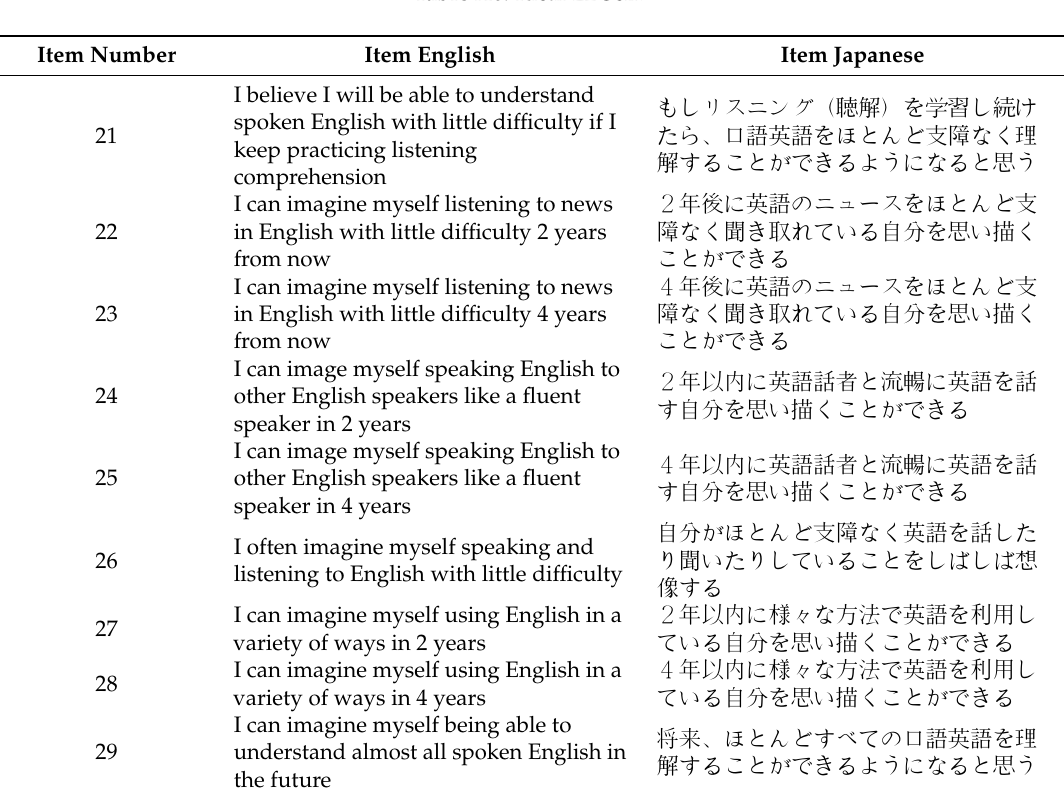
Table A6. Ideal L2 Self.